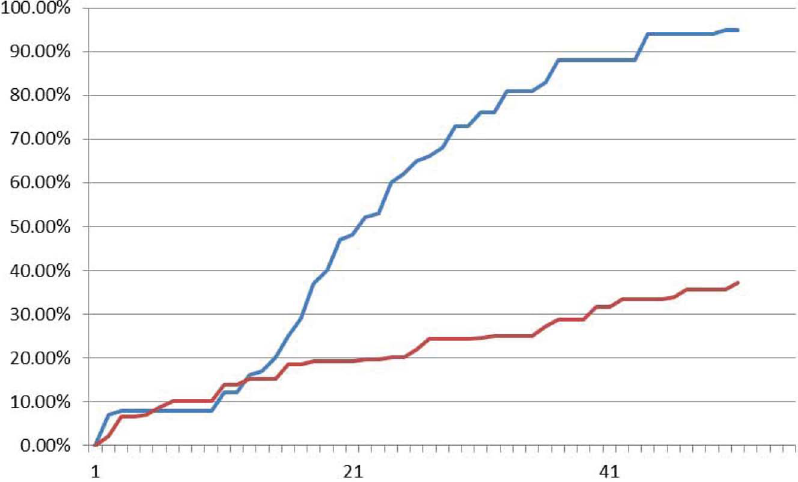
Figure 18. Fluoroscence data of DNA Neurons execute XOR logic with input ‘‘11’’. The X-axis is cycling time of Real-time PCR, the time span of each cycle is 10 minutes, temperature of each cycle keeps in 24–25 u C. The Y-axis is relative intensity of HEX (red curve) and FAM (blue curve).